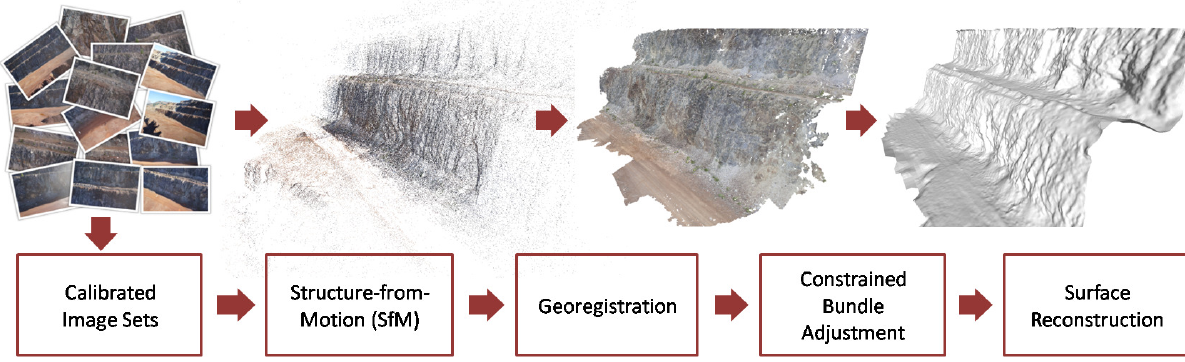
Figure 1: Automated processing workflow for geo-accurate reconstructions. Top row: Image set, sparse reconstruction, dense point cloud and triangle-based surface mesh of a quarry wall in open pit